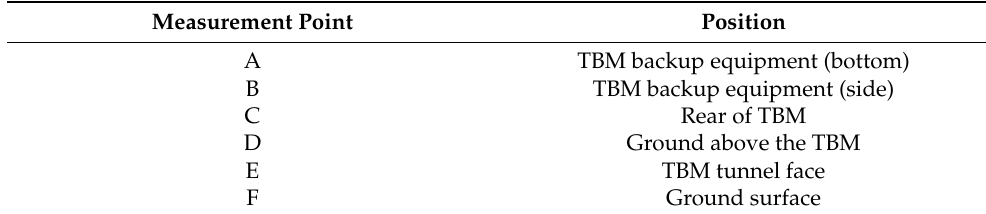
Table 8. Numerical analysis case classification.